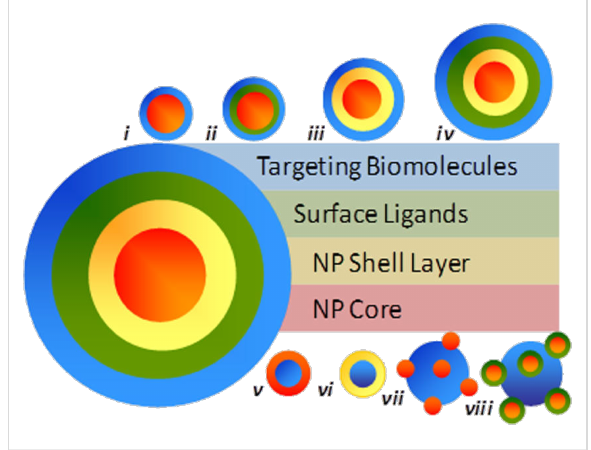
Figure 2: Hybrid nature of typical NPs, comprising different structural compartments. Reproduced with permission from [13]. Copyright (2013) American Chemical